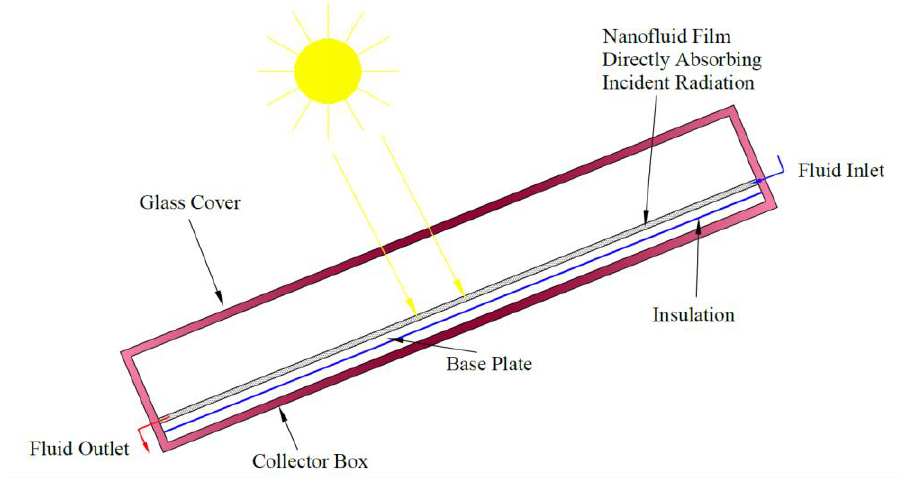
Fig. 8. The schematic diagram of DASCs for experimentation [107].